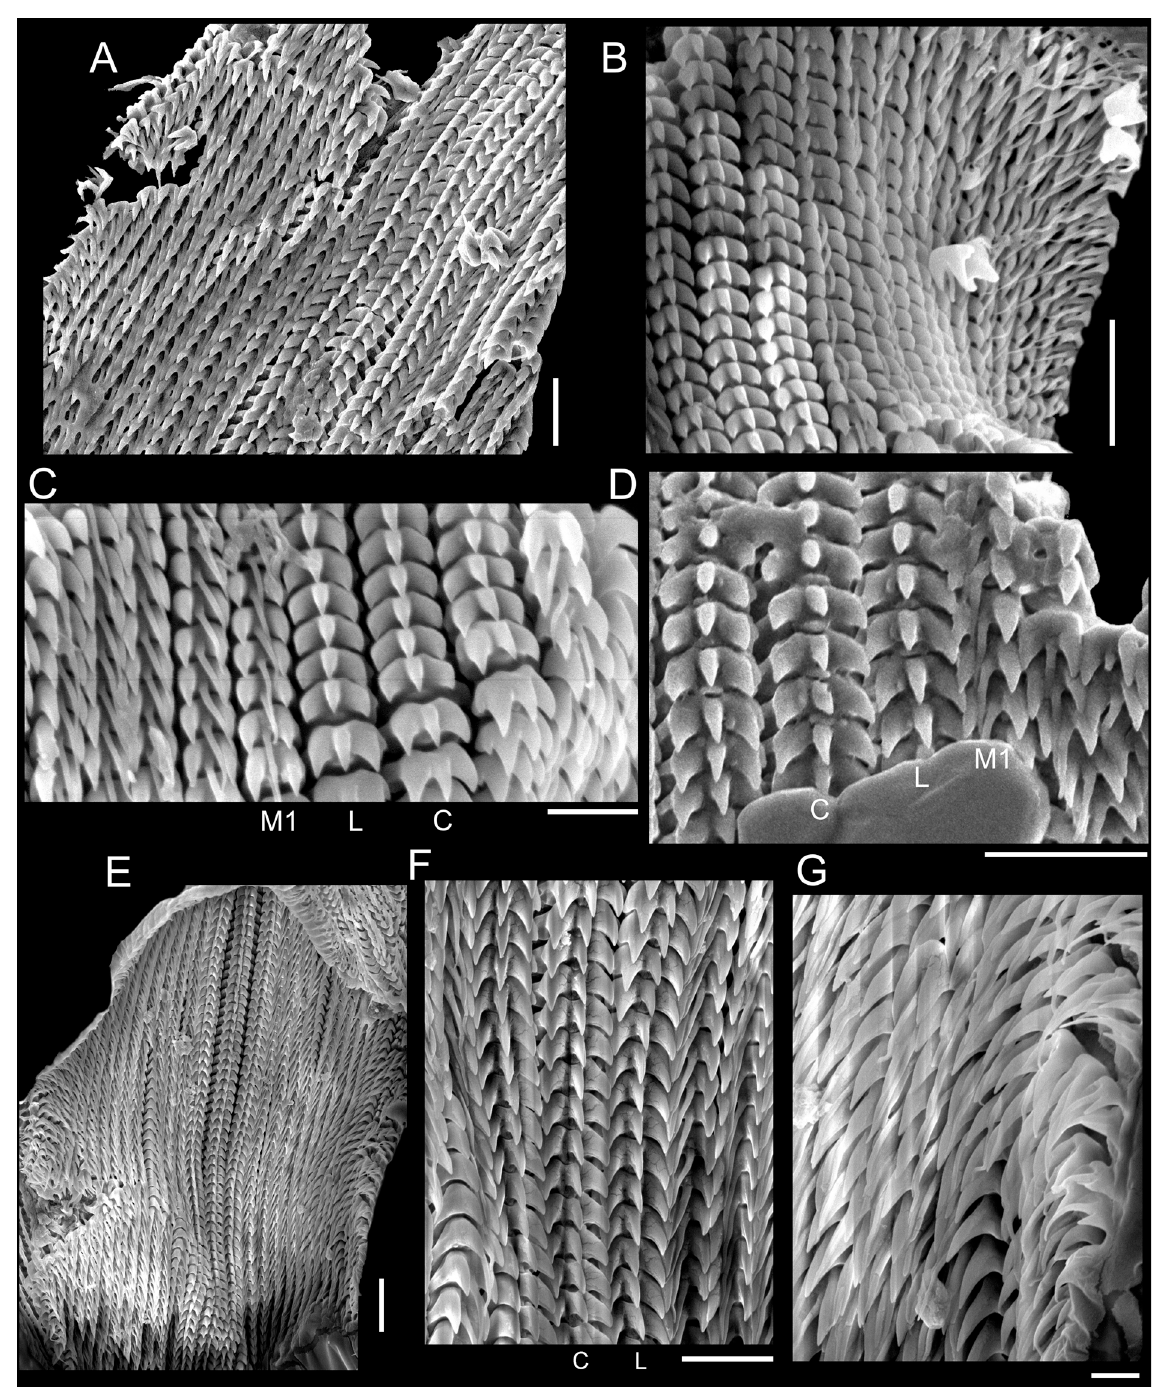
Fig. 27. Similiphora intermedia (C.B. Adams, 1850), radula. A–D . MNRJ 30854. E–G . MNRJ 29763. Scale bars: A–B, D–E = 10 µm C, F = 5 µm; G = 2